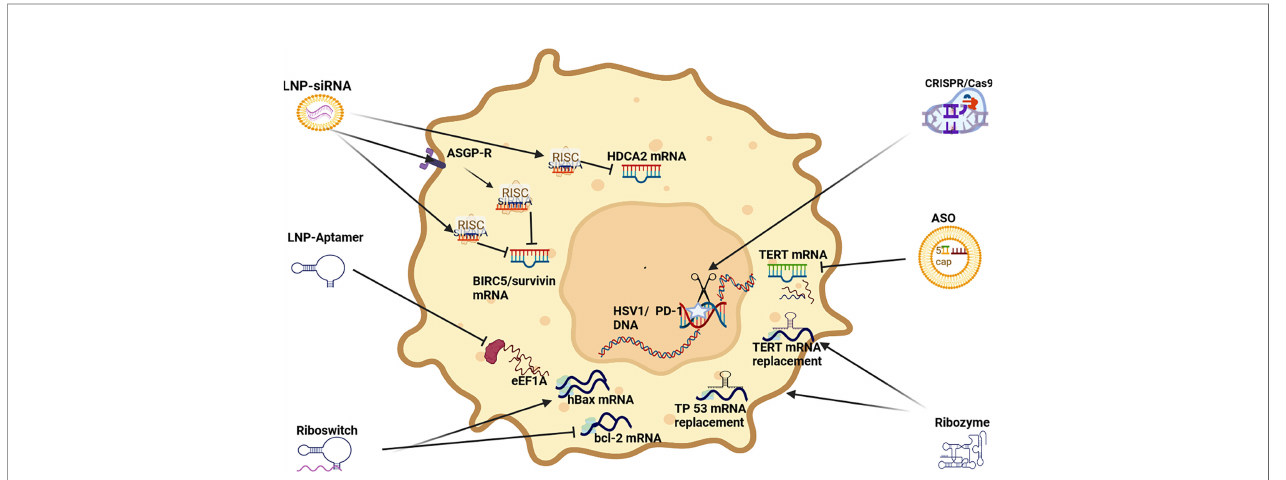
FIGURE 5 | RNAi apoptosis strategies LNP-siRNA (Lipid nanoparticles for targeted small interfering RNA delivery), CRISPR/Cas9 V (clustered regularly interspaced short palindromic repeats/CRISPR-associated protein 9), LNP-ASO (lipid nanoparticle associated antisense oligonucleotide), siRNA (small interfering RNA); HIF-1 a (hypoxia-inducible factor 1-alpha, a subunit of a heterodimeric transcription factor hypoxia-inducible factor 1 that is encoded by the HIF1A gene), TERT (telomerase reverse transcriptase), hBAX (human Bcl-2-associated X protein, apoptosis regulator), eEF1A (Eukaryotic translation elongation factors 1 alpha), BIRC5/Survivin (baculoviral inhibitor of apoptosis repeat-containing 5 or survivin), RISC (RNA-induced silencing complex), ASGP-R (asialoglycoprotein receptor), HDCA2 (histone deacetylase 2, deacetylates lysine of N ’ terminal of core